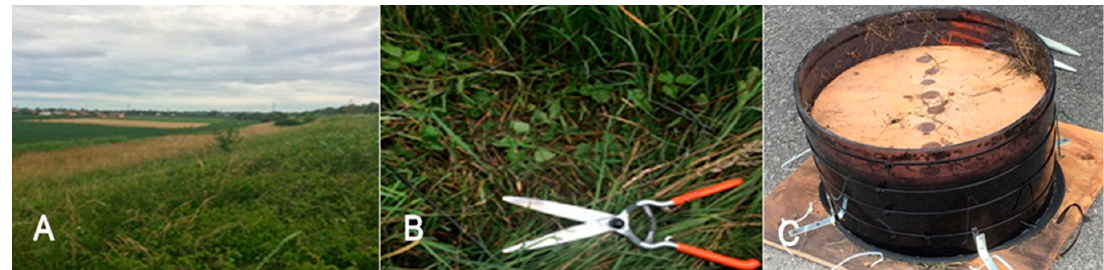
Figure 1. View of the harvesting area ( A ), detail of the cutting ( B ), and of the small-scale silo ( C ).